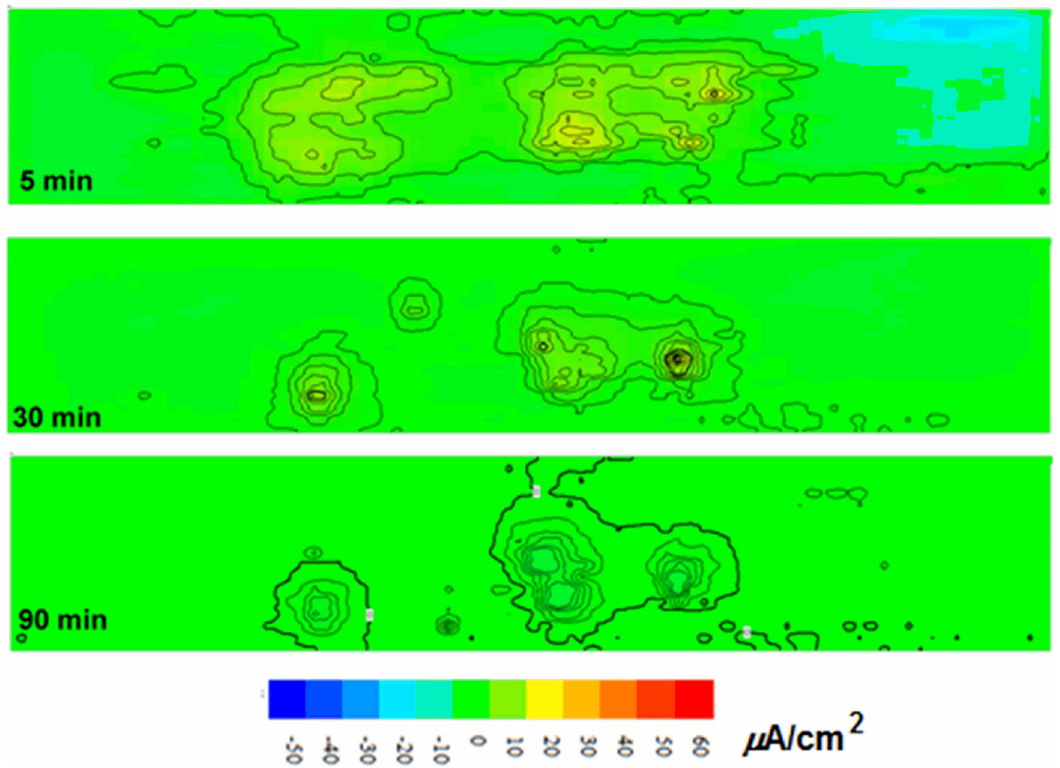
Figure 8. SVET ionic current maps obtained for SAE 1008 carbon steel after 5, 30 and 90 minutes of immersion in 0.001 0.5 mol L -1 HCl solution in the presence of 1.77 g L -1